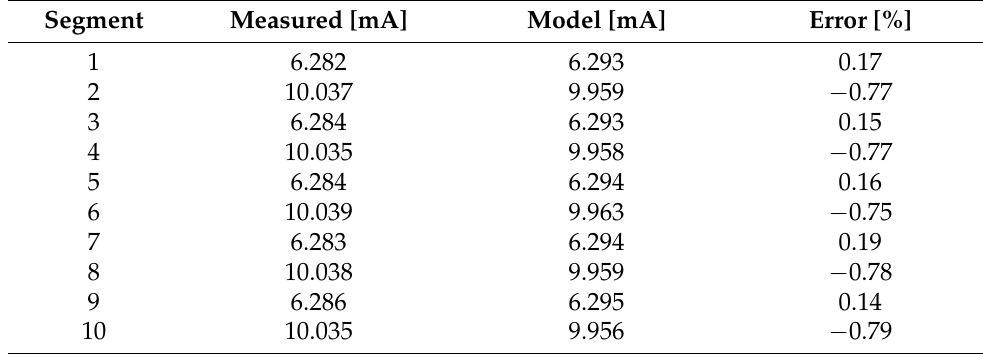
Table 3. Real-world example measurements and